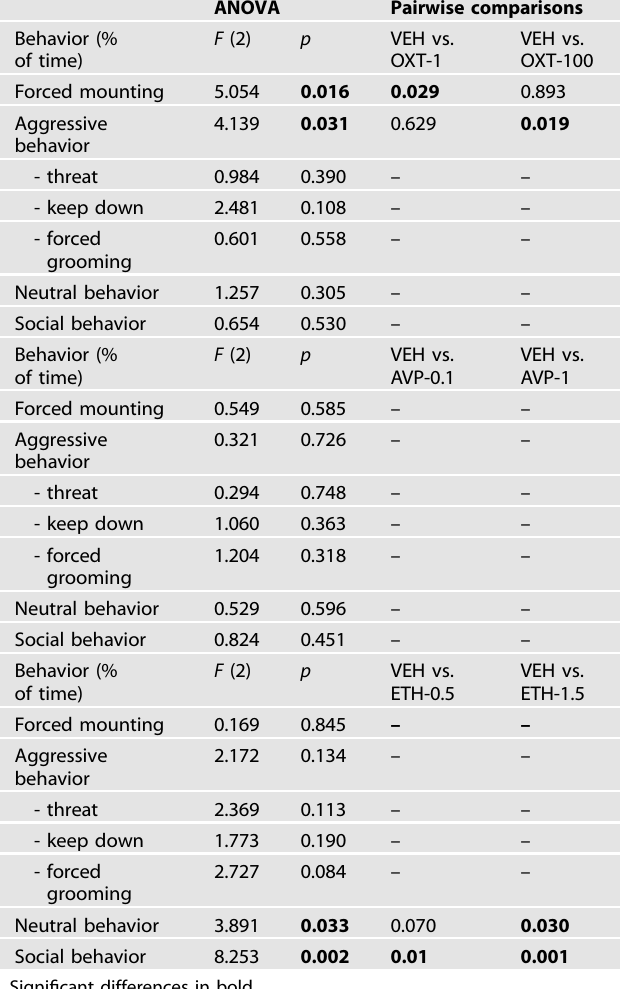
Table 3. Overview of ANOVA and, if appropriate, post-hoc pairwise comparisons of the percentage of time displaying four main categories of behaviors (plus individual aggressive behaviors) in a 10 min SxAT in response to i.c.v. infusions of OXT or AVP vs. VEH, or IP injections of ETH vs. VEH.